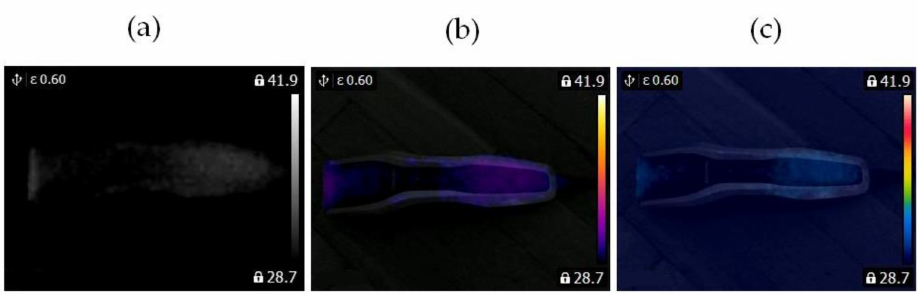
Figure 9. Healthy clipper: ( a ) gray-scale, ( b ) iron scale, ( c ) rainbow